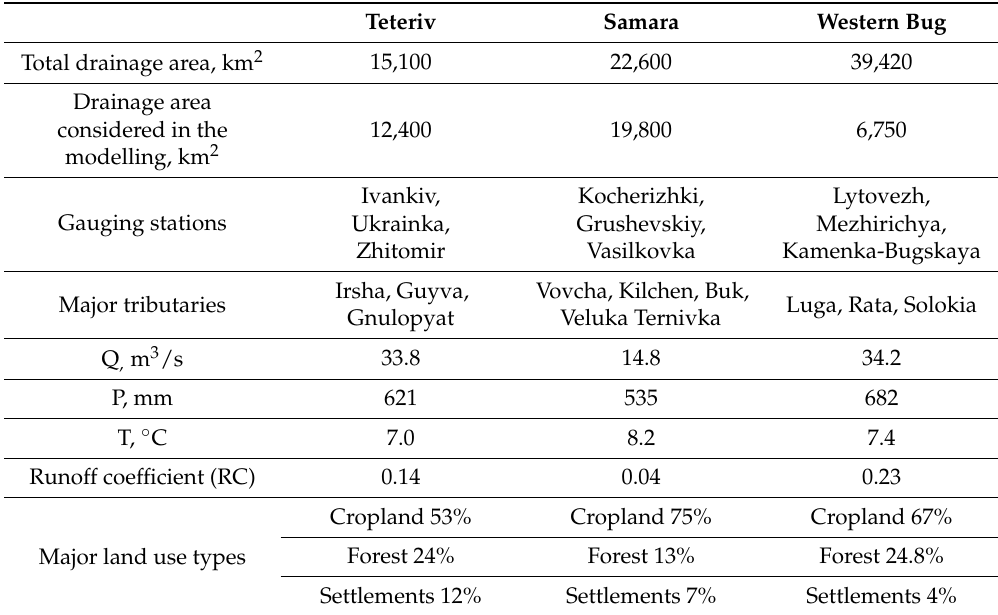
Table 1. The major characteristics of the basins under study (average annual temperature (T), precipitation (P), runoff (Q), and runoff coefficient